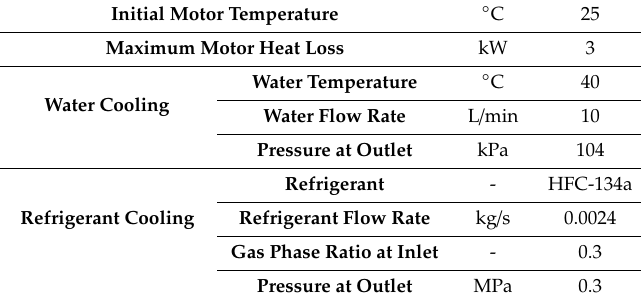
Figure 3. Simulation model.